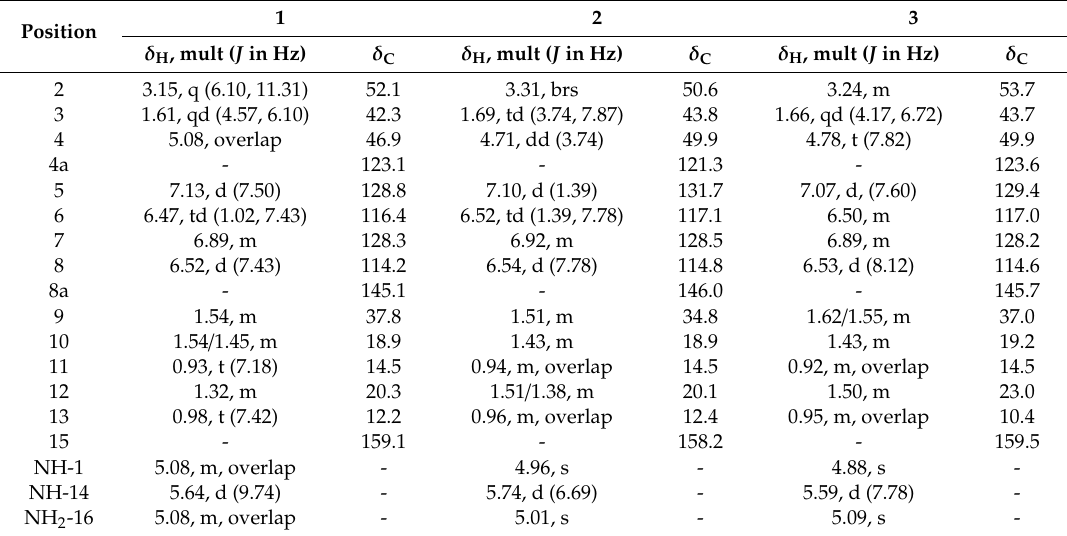
Figure 2. The 1 H- 1 H correlation spectroscopy (COSY), heteronuclear multiple bond correlation (HMBC), and selected key nuclear Overhauser enhancement spectroscopy (NOESY) correlations of 1–3. Table 2. 1 H and 13 C NMR spectroscopic data for compounds 1 – 3 (600 MHz, acetone- d 6